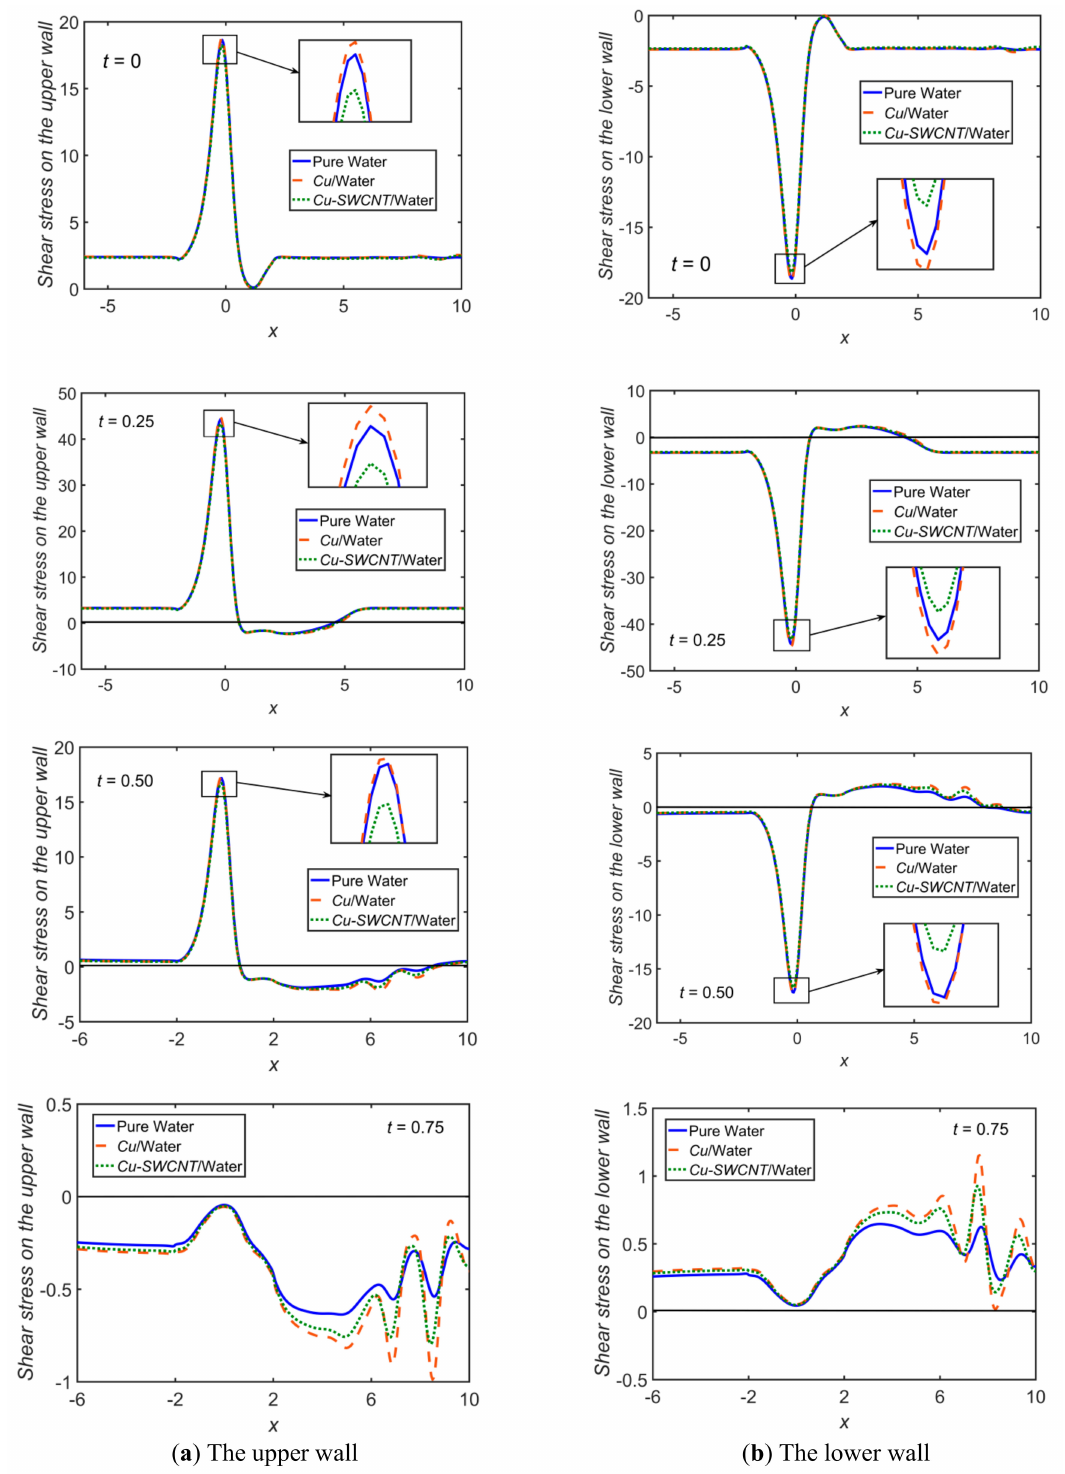
Figure 3. Comparison of pure water, Cu /water, and Cu – SWCNT /water for WSS with M = 5, Pr = 1, Rd = 0.2, Re = 700, and φ = 0.02, at t = 0, 0.25, 0.50, and